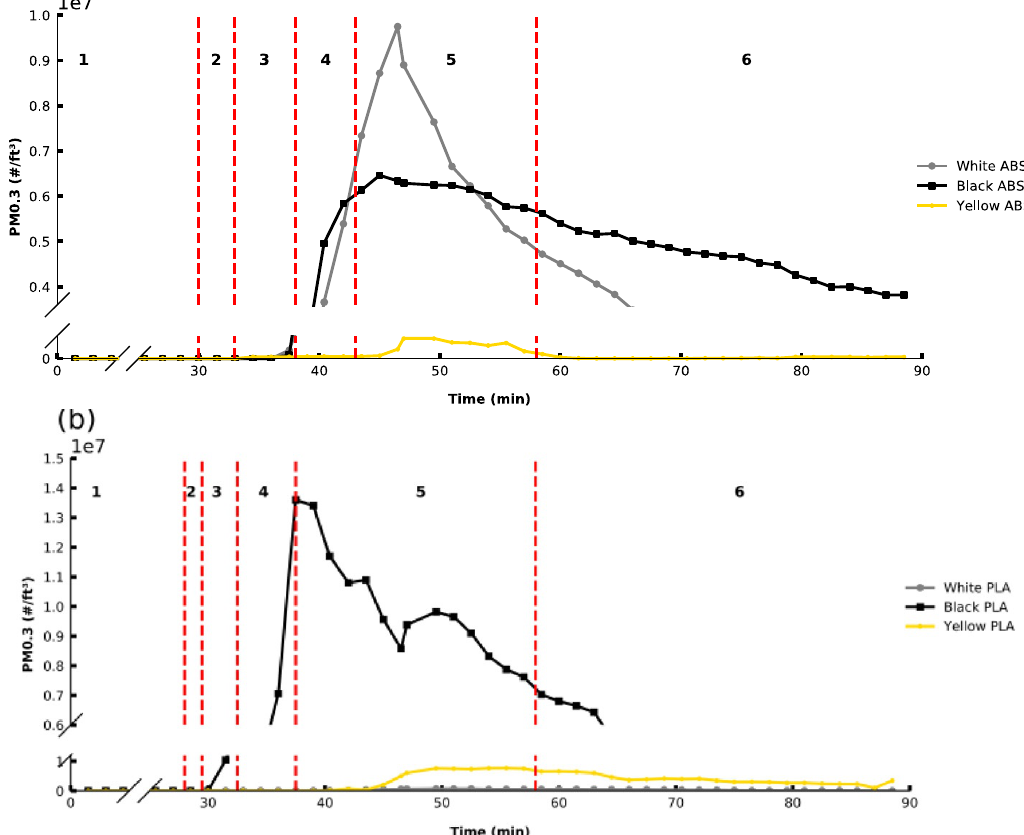
Figure 2. PM 0.3 emissions over before, during, and after printing of a cube in different colors for ( a ) ABSB5 (bedplate temperature: 80 °C, extruder temp: 245 °C, 0% fan, 20% infill) and ( b ) PLAB8 (bedplate temperature: 50 °C, extruder temp: 205 °C, 20% fan, 20% infill).